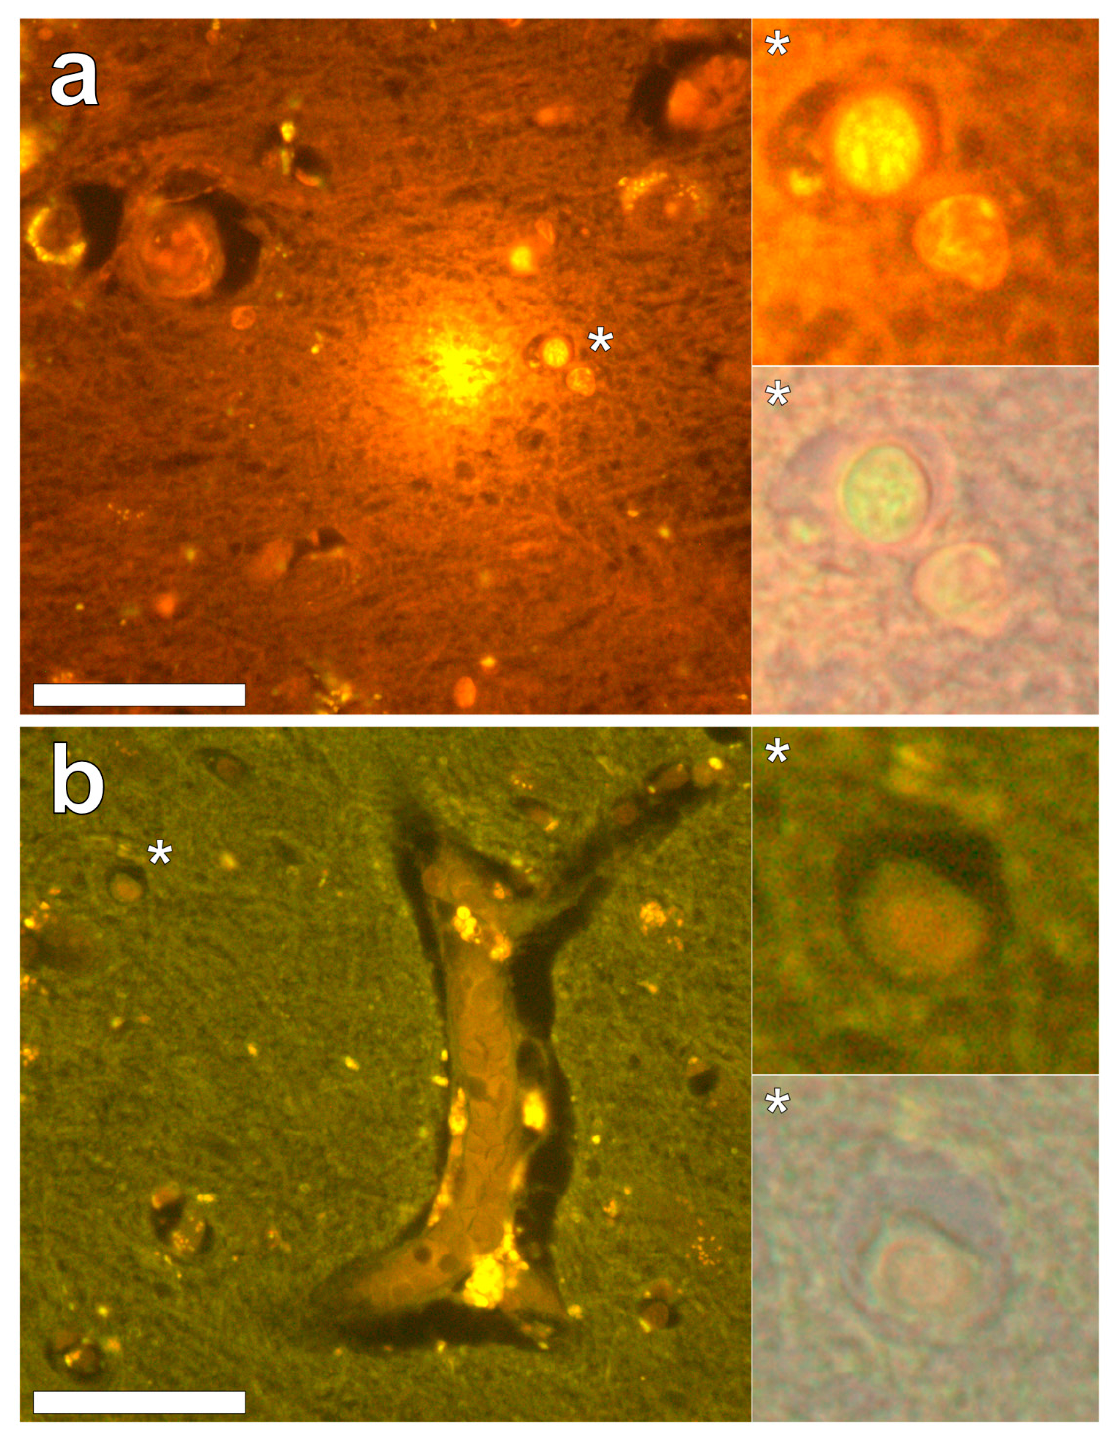
Figure 1. Aluminium-loaded cells in the frontal cortex, morphologically compatible with glia, identified by punctate orange fluorescence, are in close proximity to aluminium-rich extracellular debris ( a ) Lumogallion staining of the parietal lobe ( b ) is negative for the presence of aluminium with cortical lipofuscin deposits highlighted via yellow fluorescence. Magnified inserts are denoted by asterisks, including a bright-field overlay in the lower panels. Magnification × 400, scale bars: 50 µm.